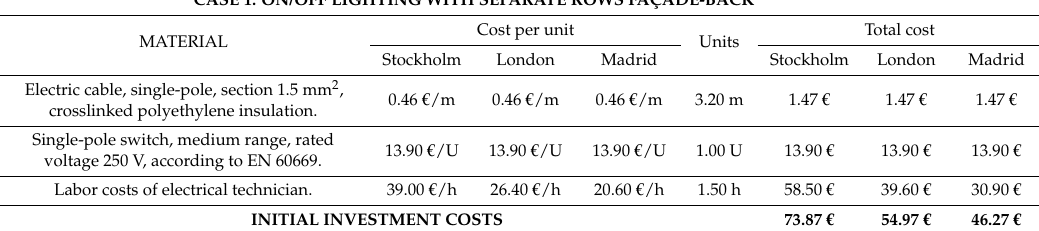
Table 2. Estimated initial investment costs of the proposed smart